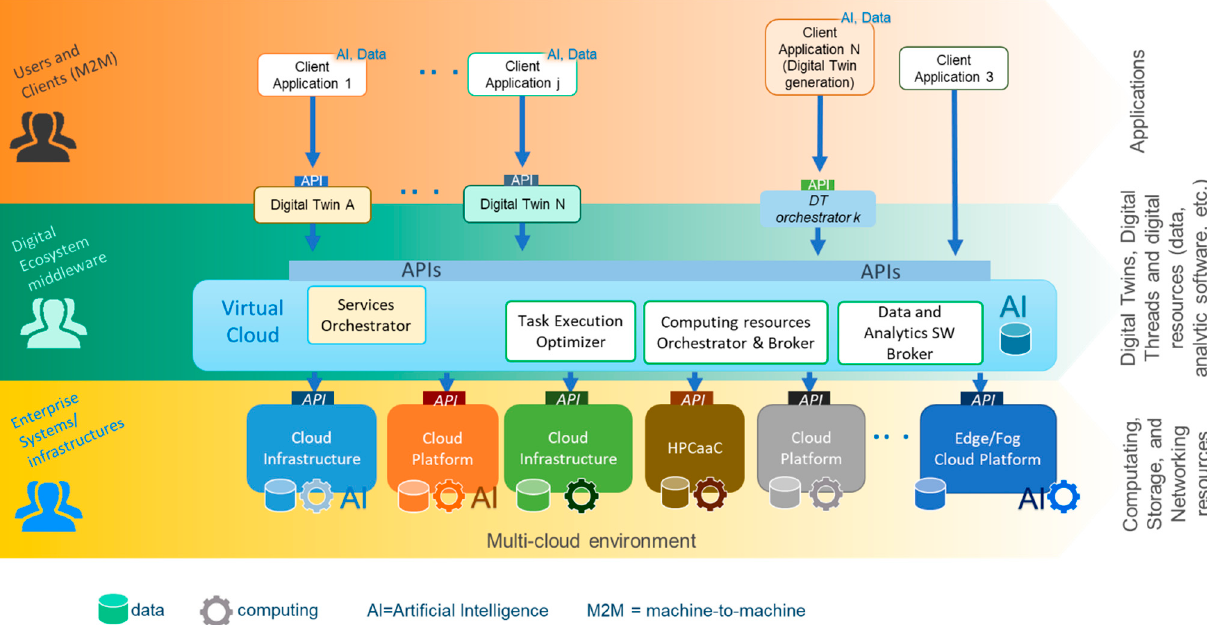
Figure 9. DE technological framework based on the Virtual-Cloud paradigm .